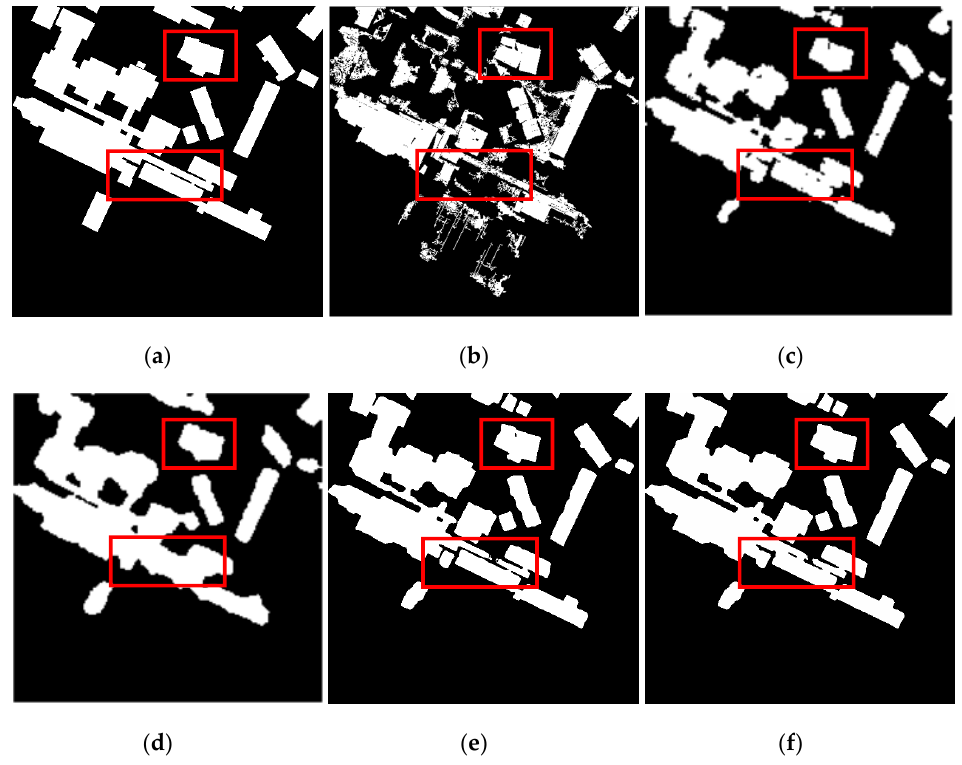
Figure 8. The building extraction results of image 2. ( a ) Label; ( b ) DPSCRF; ( c ) FullCRF; ( d ) ConvCRF; ( e ) D ‐ LinkNet; ( f ) MSCRF.